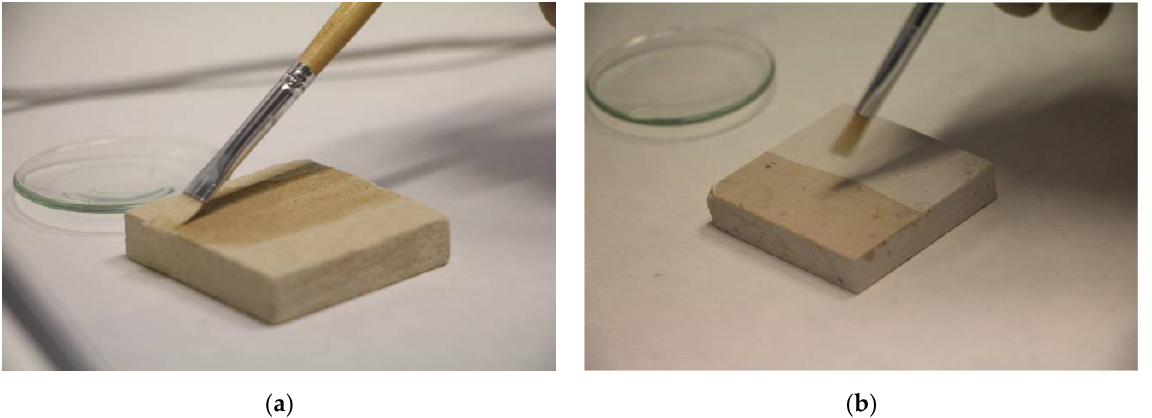
Figure 1. Application by brush of the nanoF product on samples of ( a ) porous stone (PS samples) and ( b ) compact stone (CS samples).